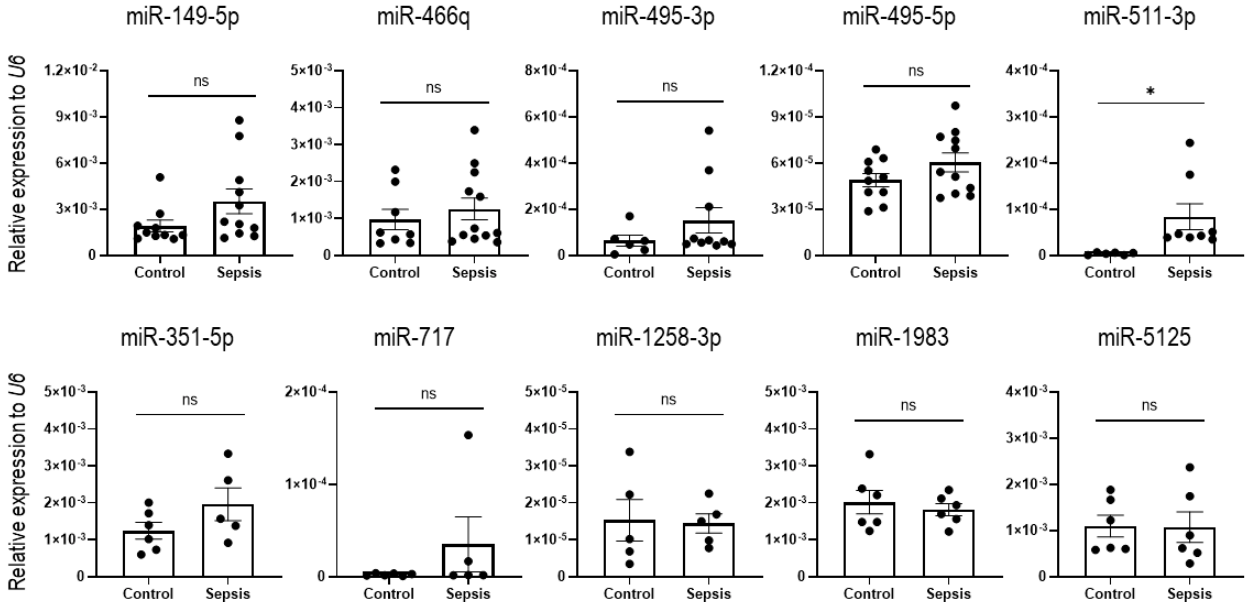
Figure 7. Validation of identified candidate miRNAs in blood. The expression of the miRNAs upregulated (upper) and downregulated (lower graphs) was analyzed with RNA extracted from the blood samples of sham and sepsis mice by using RT-qPCR analysis. U6 was used as an endogenous control to normalize miRNA expression levels. Data are shown as scatter plots and bars overlaid with the mean ± standard error of the mean (SEM). Dot on the plot represents the value of each mouse. Control and sepsis indicate the blood samples drawn from sham and sepsis cohorts, respectively. * p < 0.05 and ns, not significant.